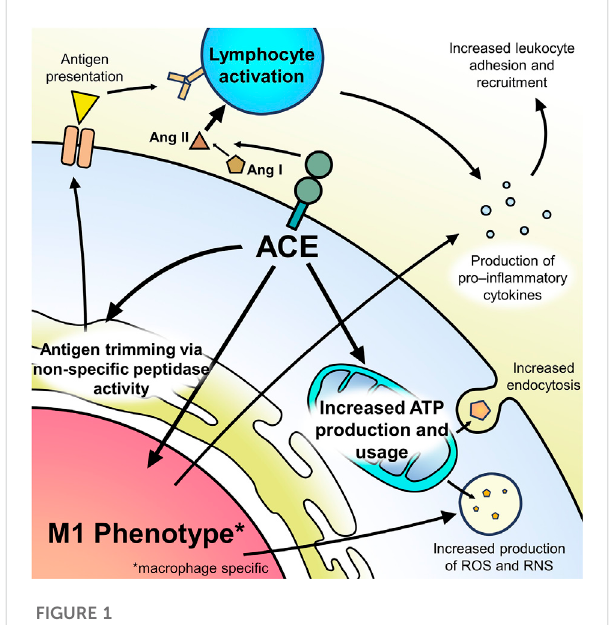
FIGURE 1 Summary of ACE ’ s effect on immune cell